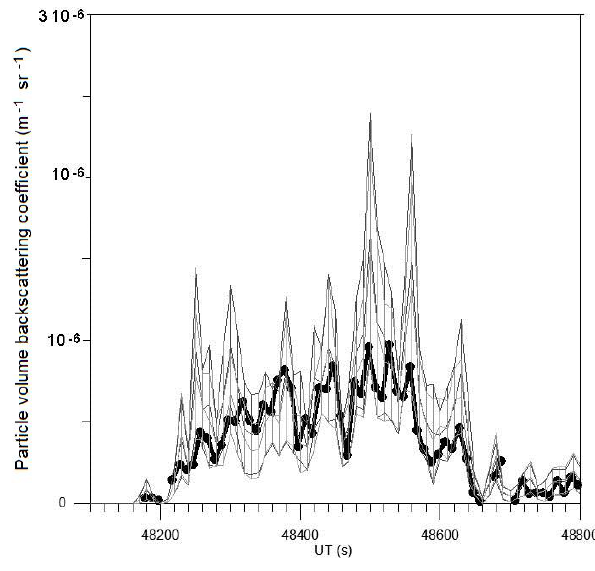
Fig. 4. Time series of aerosol backscattering coefficient β are dis- played, for a portion of the M55 Geophysica flight in cloudy air. The black line represents the parameter measured by the backscat- tersonde, the grey area superimposed to it represent the same pa- rameter computed from the measured size distribution, allowing an upper and a lower limit provided by the uncertainties on the particle counting statistics.